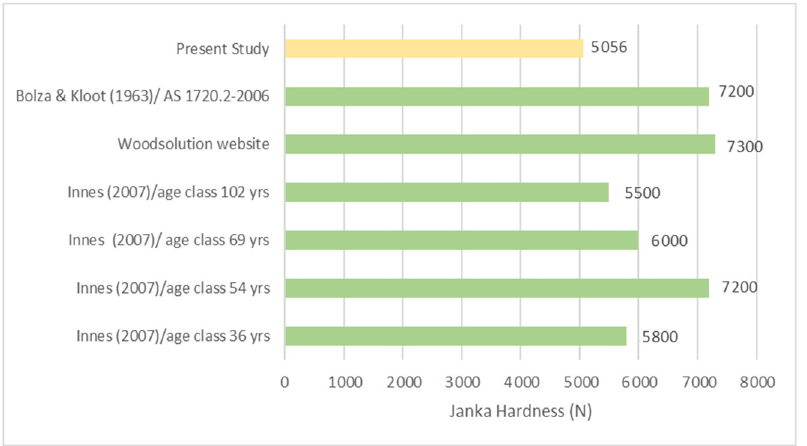
Figure 9. Comparing the Janka hardness of E. obliqua .